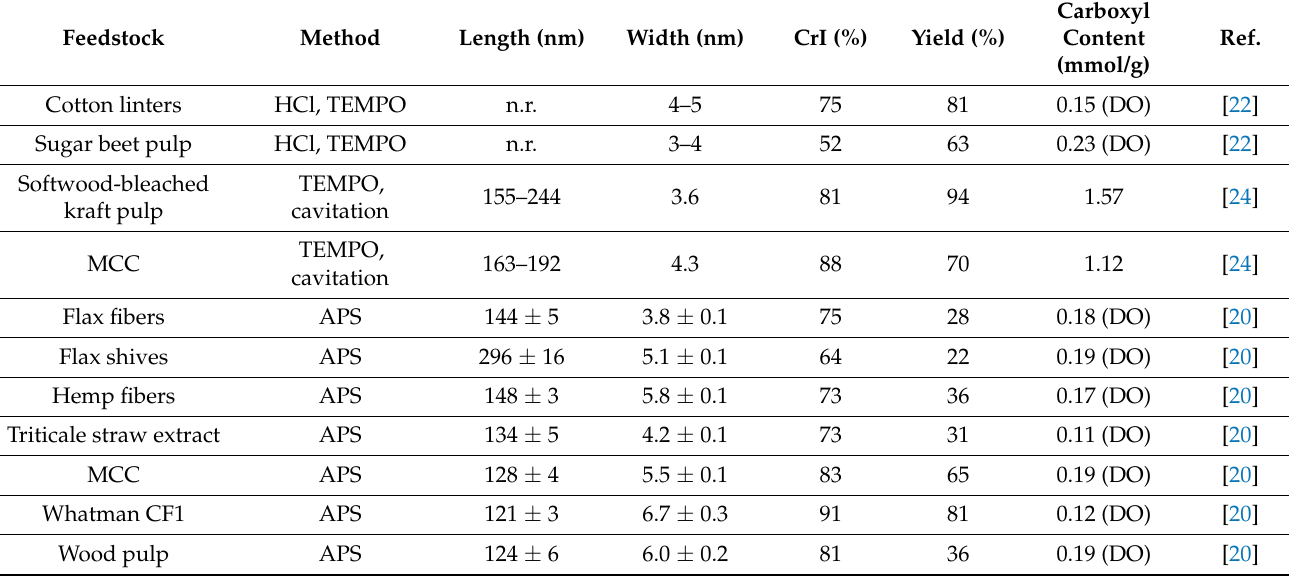
Table 1. Production of cCNCs from different feedstock